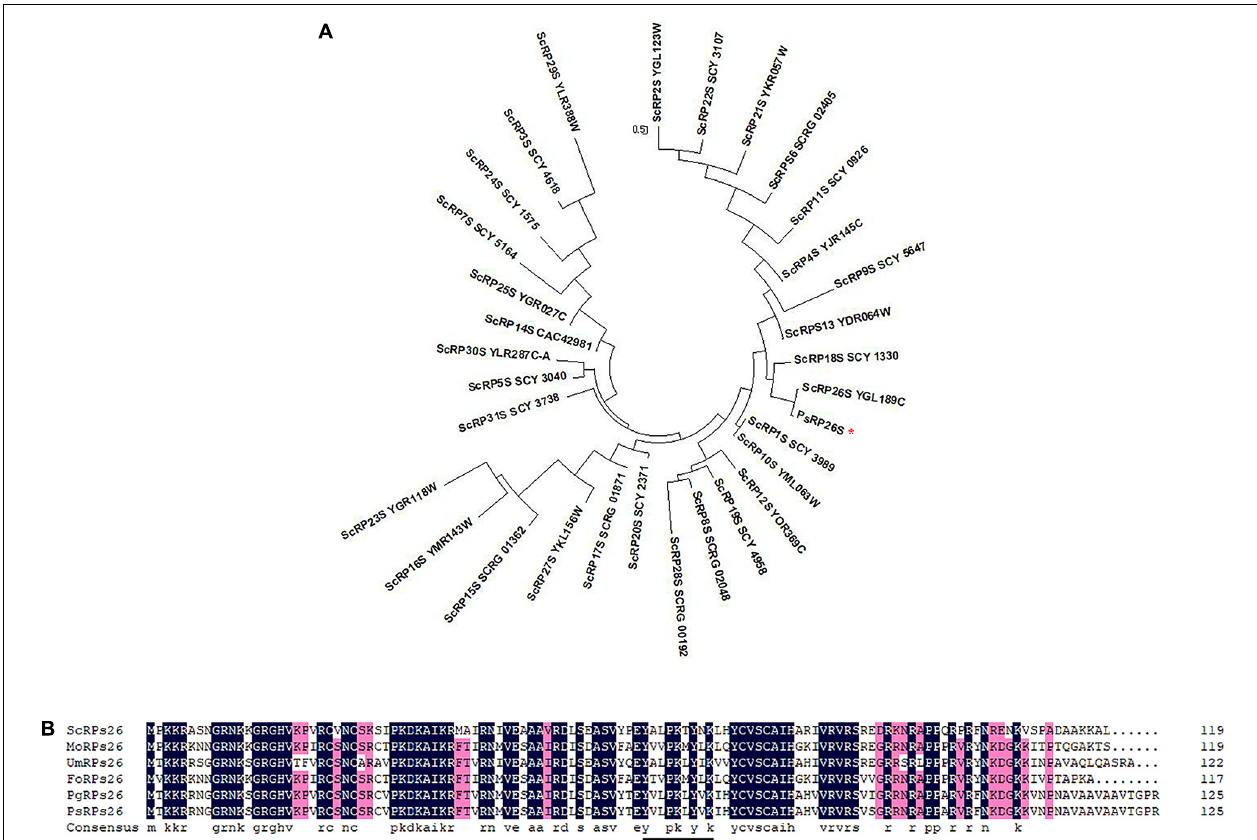
FIGURE 1 | Phylogenetic analysis and multiple sequence alignment of PsRPs26. (A) Phylogenic analysis of PsRPs26 and Saccharomyces cerevisiae RPs family members using MEGA 5.0 software. (B) Protein multiple alignment. Identical and similar amino acid residues are shaded in black and light gray, respectively. Ps, Puccinia striiformis f. sp. tritici ; Pg, Puccinia graminis f. sp. tritici ; Us, Ustilago maydis ; Mo, Magnaporthe oryzae ; Fo, Fusarium oxysporum ; and Sc, Saccharomyces cerevisiae